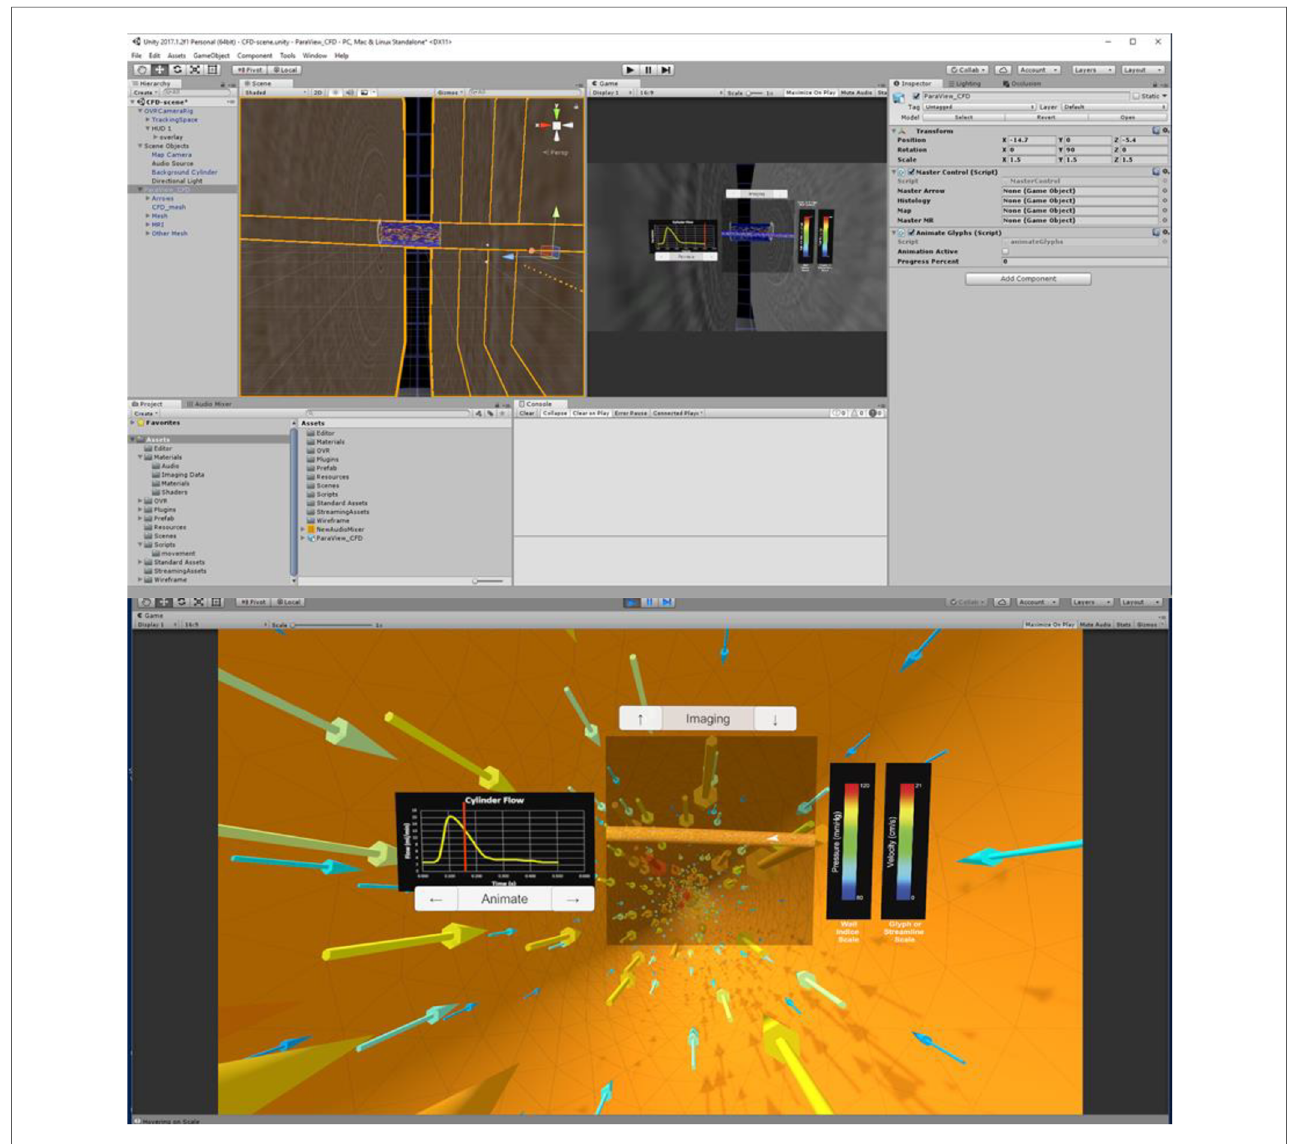
FIGURE 3 Screenshots of Unity ’ s interface upon completing the steps described for the cylinder CFD simulation. “ Play mode ” is shown in the top panel with a standalone stereoscopic projector output shown in the bottom panel.